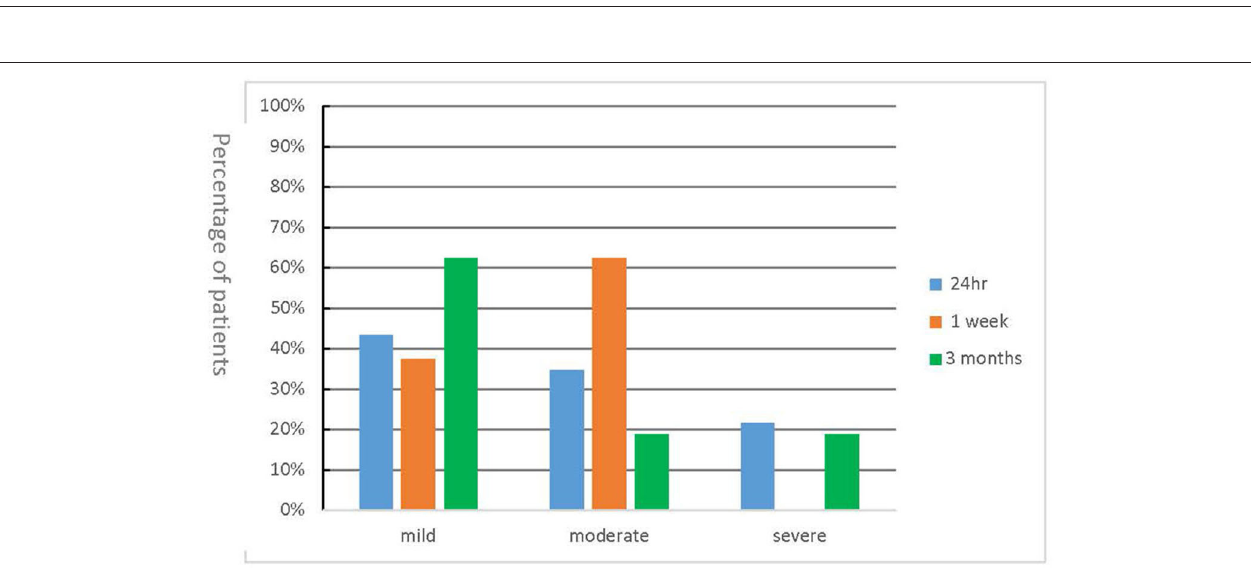
FIGURE 2 | Incidence of post-operative pain. Patients were contacted via phone call at 24 h, 1 week, and 3 months after the procedure and a standardized questionnaire was used to collect data on the incidence of post-operative pain.